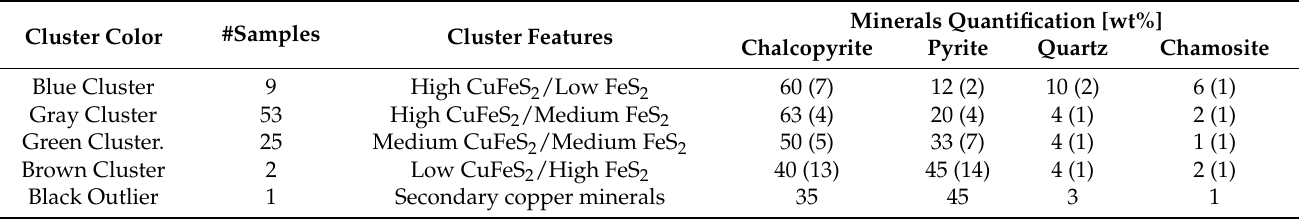
Table 3. Average weight percentages of selected minerals of different clusters of copper concentrate, as determined by Rietveld refinements. The mineral variability within the same cluster is reported as the standard variation in between brackets. #Samples represents the number of samples included in each